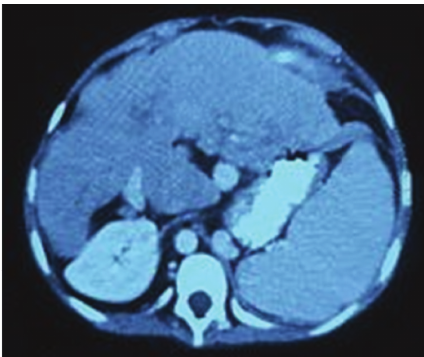
Figure 1: Preoperative angiotomography showing LGV draining splanchnic bed.